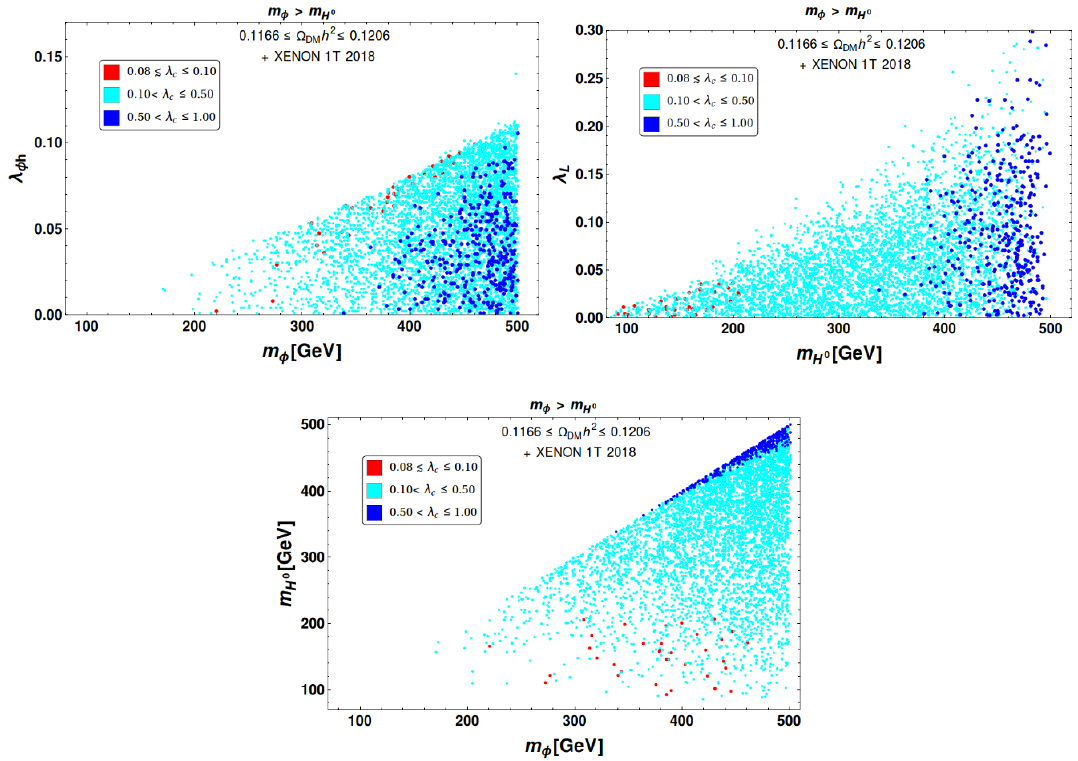
Figure 14 . Relic Density and direct detection (XENON 1T 2018) at NLO allowed parameter space is shown in: m (cid:30) (cid:0) (cid:21) (cid:30)h plane (top left panel), m plane (bottom panel). The scans are performed for the mass hierarchy m (cid:30) > m